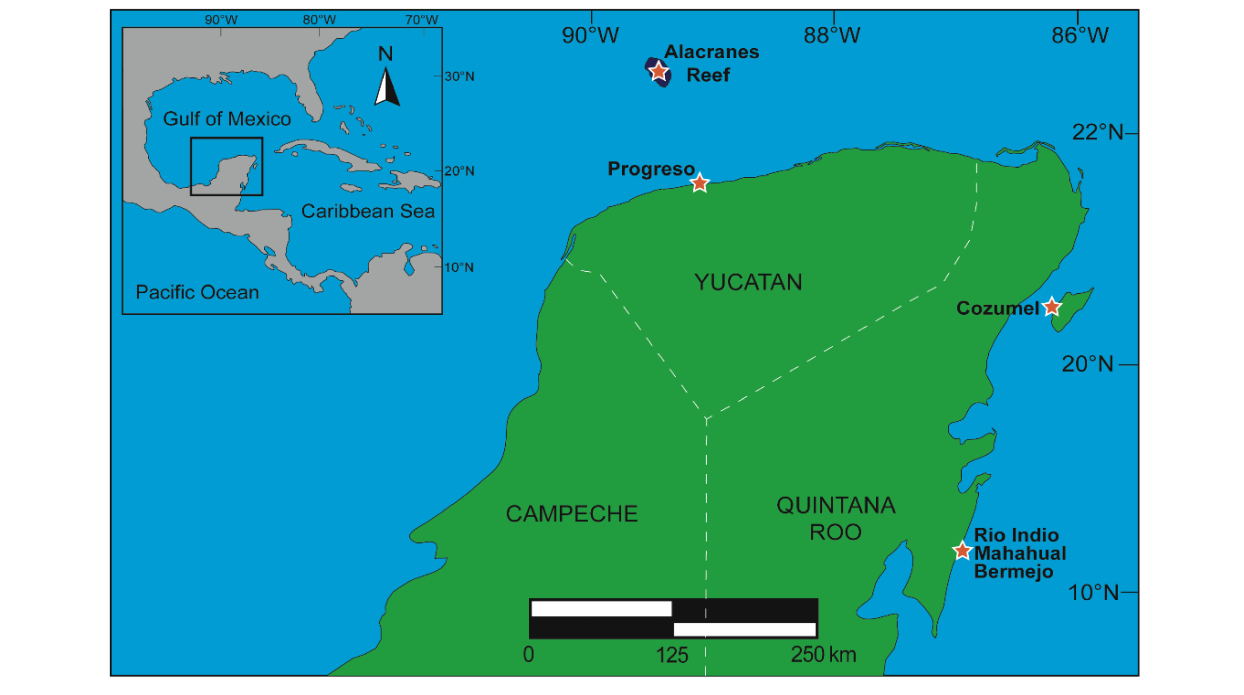
FIGURE 1 | Sites of collection of marine organisms in the Yucatan Peninsula,